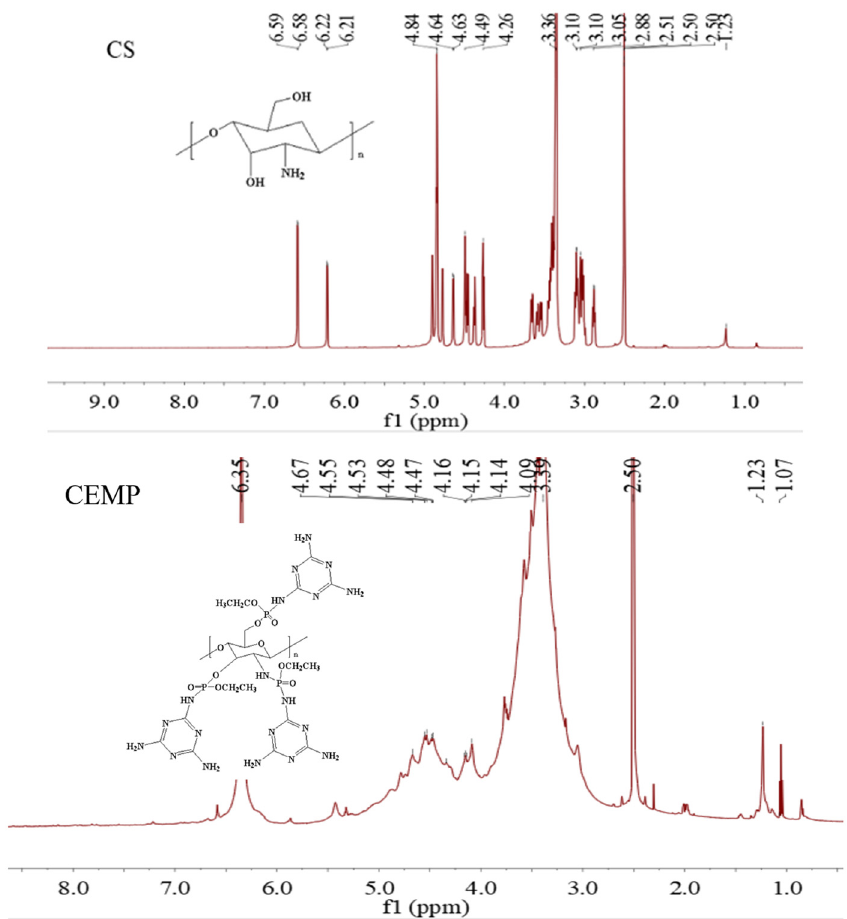
Figure 2: 1 H NMR spectra of CS and CEMP.